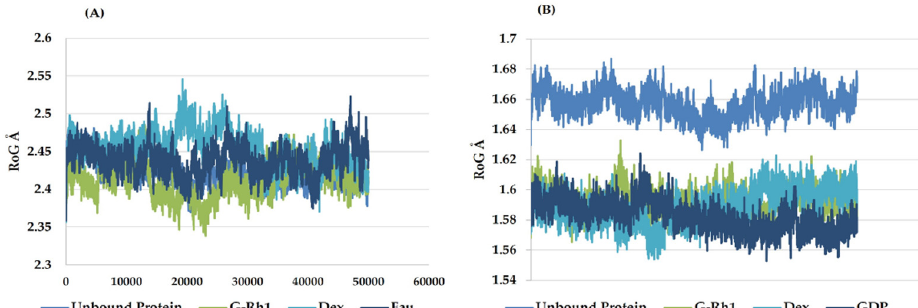
Figure 6. Radius of gyration plots of molecular dynamics (MD) simulation of ( A ) ROCK1 receptor-ginsenoside Rh1 and control (Dexamethasone, Fausidil) complexes and ( B ) RhoA receptor-ginsenoside Rh1 and control (Dexamethasone, GDP) complexes.